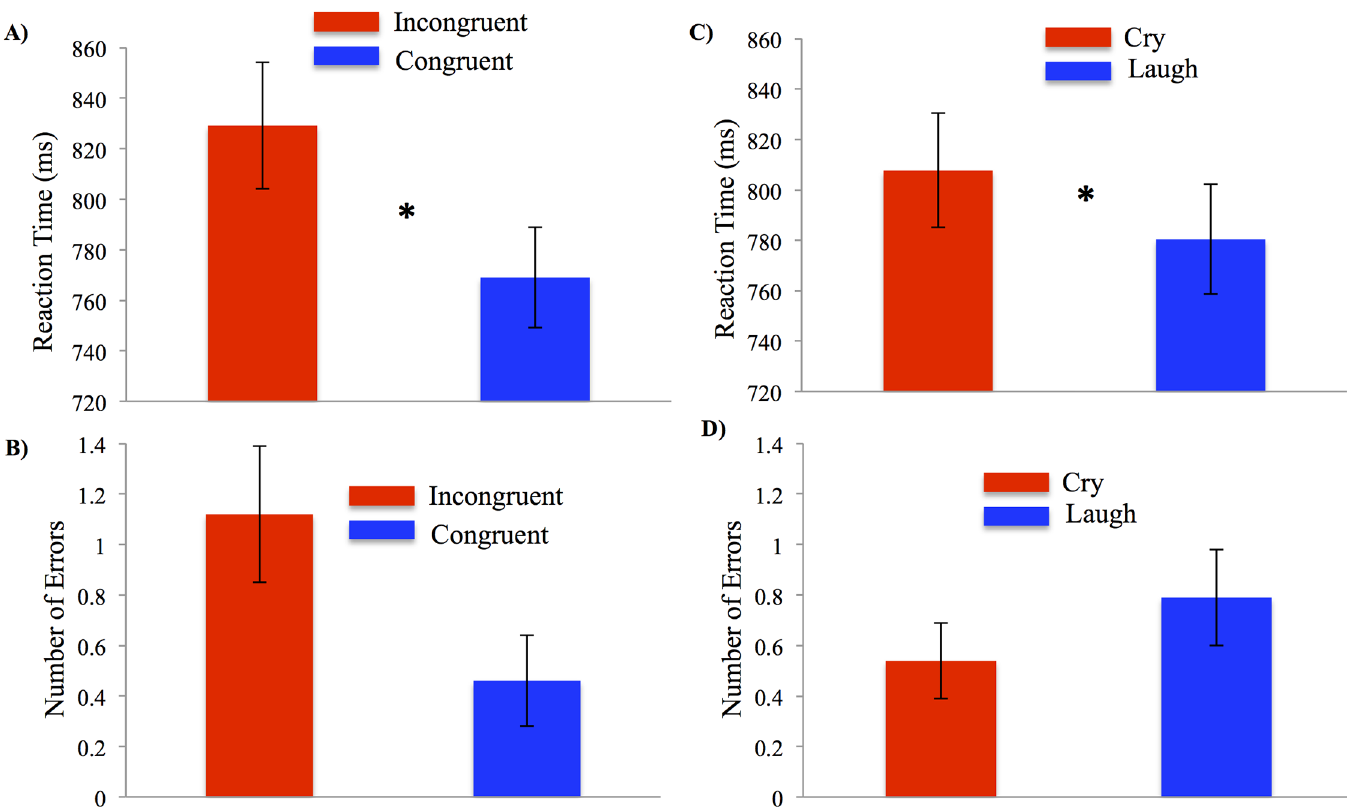
Fig 2. Performance on the sequential cross-modal distraction paradigm differed by Stroop condition and valence of infant vocalizations in Experiment 1. (A) Mean reaction time (in milliseconds, ms) and number of errors (B) for incongruent (red bars) and congruent trials (blue bars). Mean reaction time (C) and number of errors (D) for cry (red bars) and laugh (blue bars) conditions. Asterisks ( * ) represent statistical significance at p < .01 value. Error bars represent standard errors.